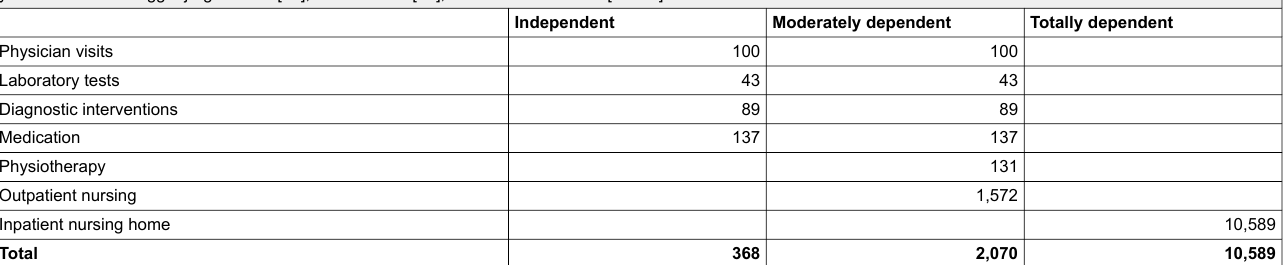
Table 2 : Composition of follow-up costs per 3-month cycle [CHF]. The follow-up costs represent the average resources an individual uses over its average lifetime after a stroke of 7.5 years. In the Markov model, the average age when experiencing a stroke is 80 years. At this age the residual life expectancy of all patients in the model is 7.5 years. Sources: Brüggenjürgen et al. [38], Mahler et al. [39], Swiss medical tariffs